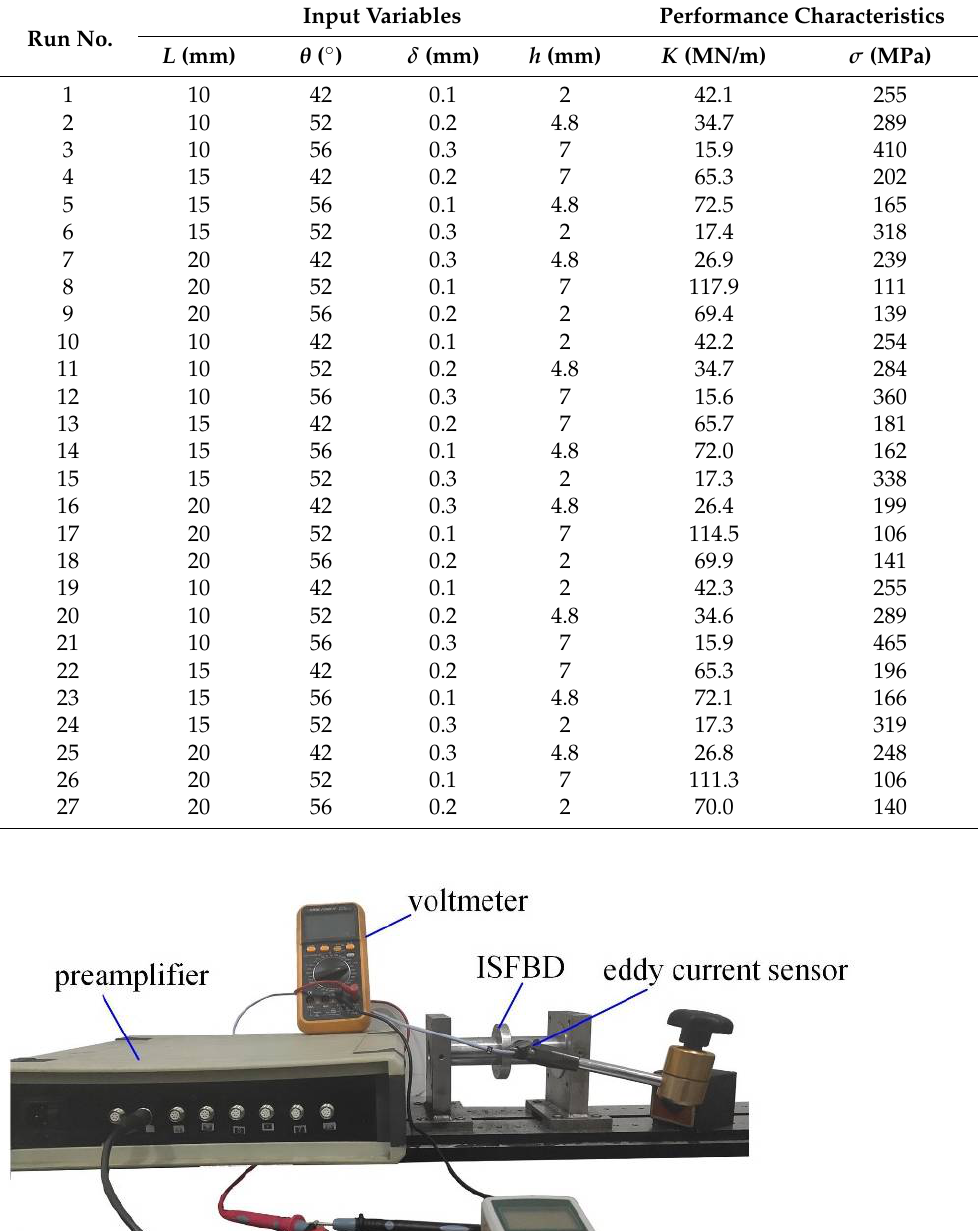
Table 1. 3 series of L 9 orthogonal repeated experiments.